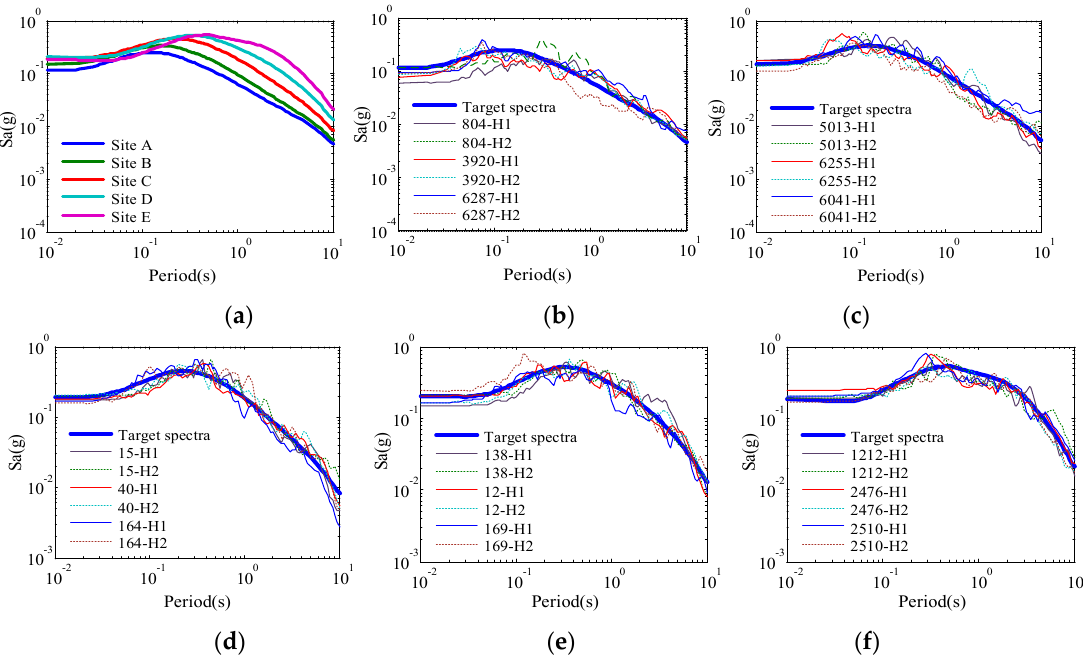
Figure 6. Spectra of selected ground motions. ( a ) Target response spectra. ( b ) Response spectra of site A. ( c ) Response spectra of site B. ( d ) Response spectra of site C. ( e ) Response spectra of site D. ( f ) Response spectra of site E.